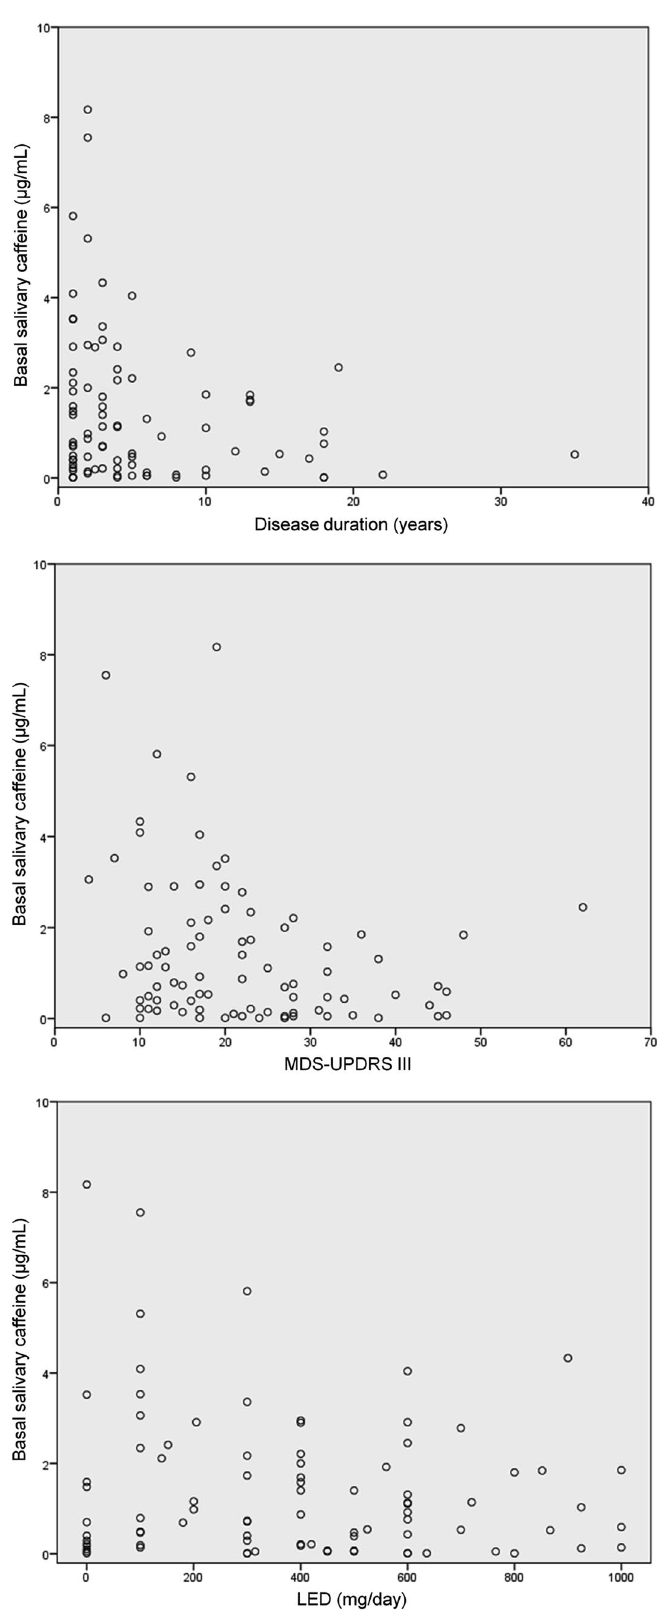
Figure 1. Basal salivary caffeine levels plotted against disease duration (top), Movement Disorder Society- sponsored revision of the Unified Parkinson’s Disease Rating Scale (MDS-UPDRS) part III score (medium), and levodopa equivalent dose (LED) (bottom) of all PD